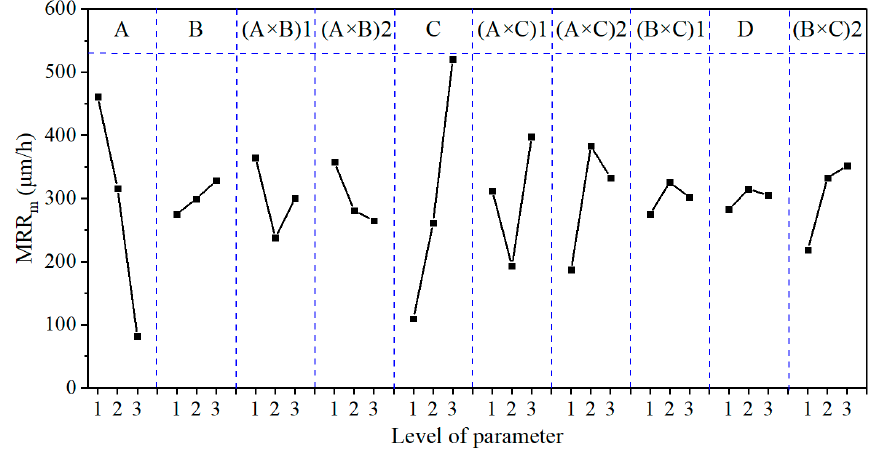
Figure 5. The effect plot for MRR m .